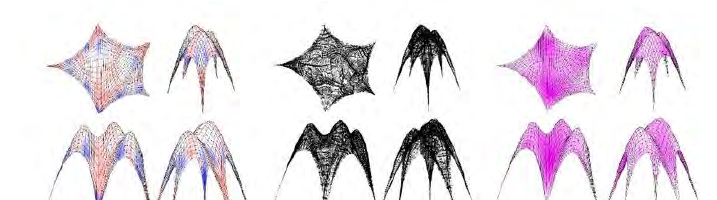
Figure 8. FEA Analysis generating stress lies and compression/tension areas of the shell was performed on an optimized shell from